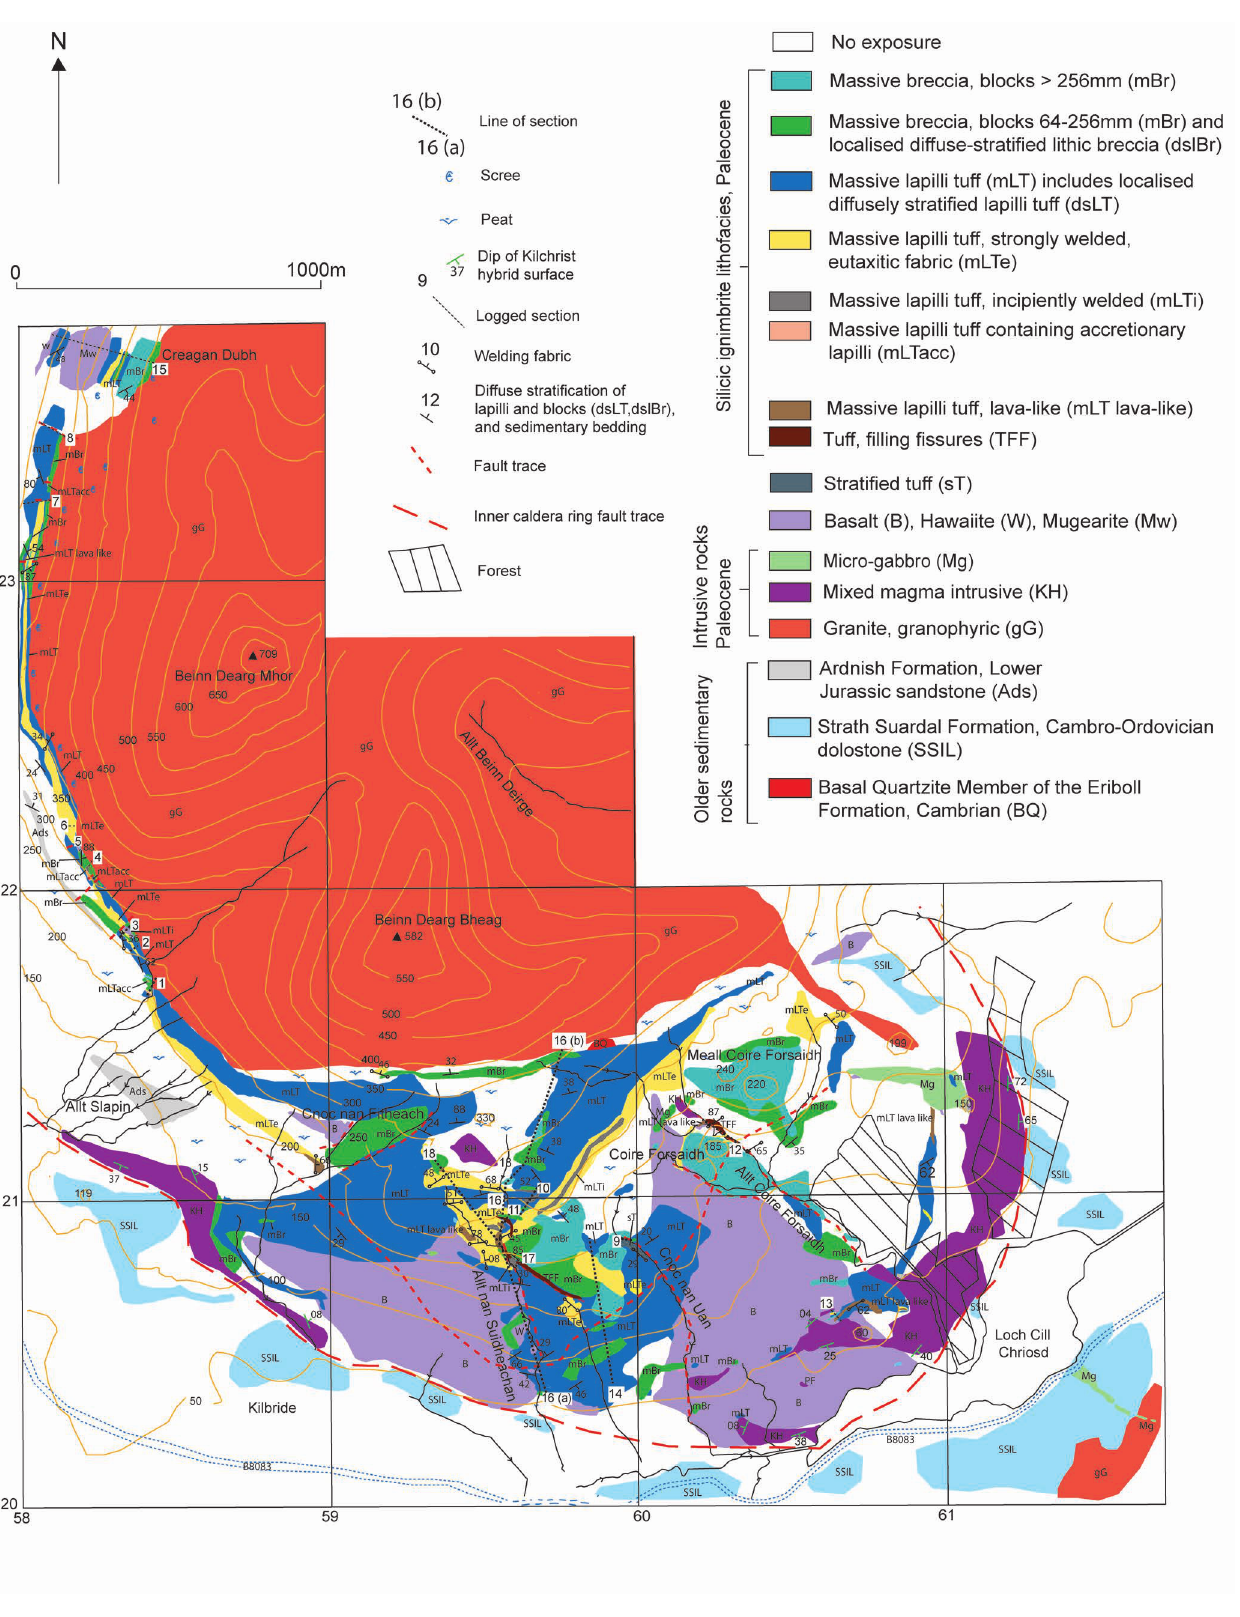
Figure 3: Geological map of the Kilchrist Volcanic Formation (KVF). The numbers round the grid correspond with the British National Grid square (NG). Logged sections 1–18 are detailed in Supplementary Material 1 and correlated in Figures 11 and 12. mBr has been subdivided into blocks 64–256 mm diameter and those >256 mm to highlight the distribution of the coarsest